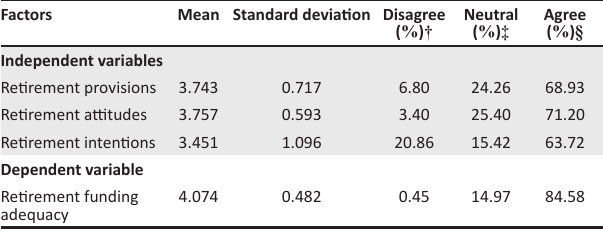
TABLE 3: Descriptive statistics of the variables ( N = 441). TABLE 2: Operational definitions, validity and reliability results.